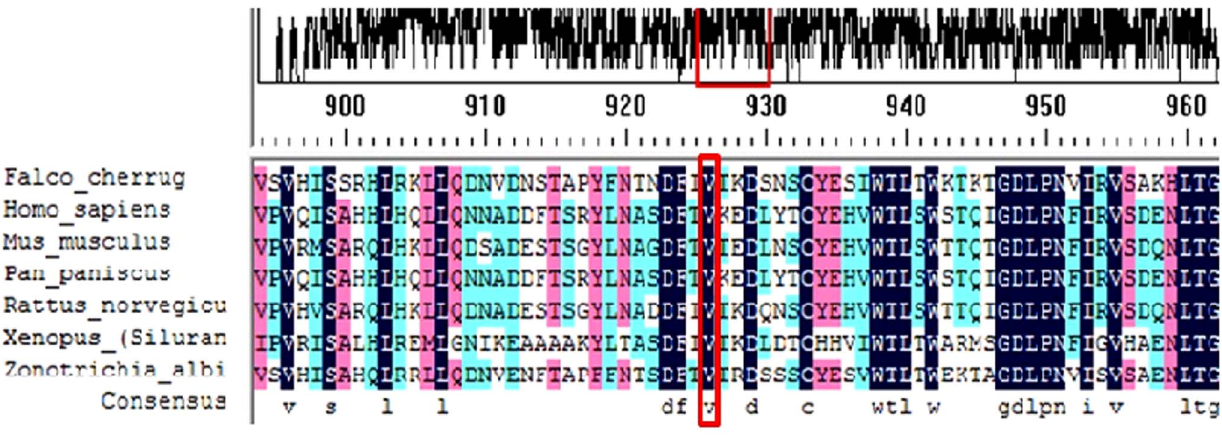
Figure 4. Multiple-sequence alignment of the PKHD1 protein including Musmusculus , Rattusnorvegicus , Panpaniscus , Xenopus (Silurana)tropicalis , Falcocherrug , Zonotrichiaalbicollis and Homosapiens . The Val 836 residue is located within a highly conserved